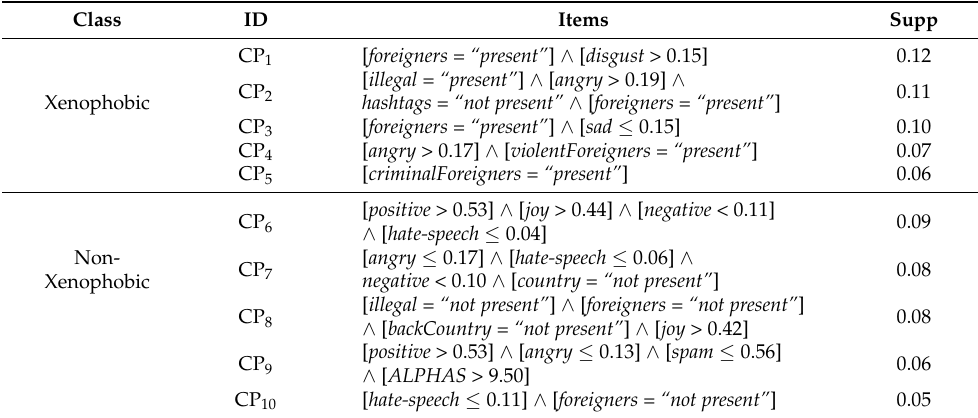
Table 12. Example of contrast patterns extracted from the Experts Xenophobic